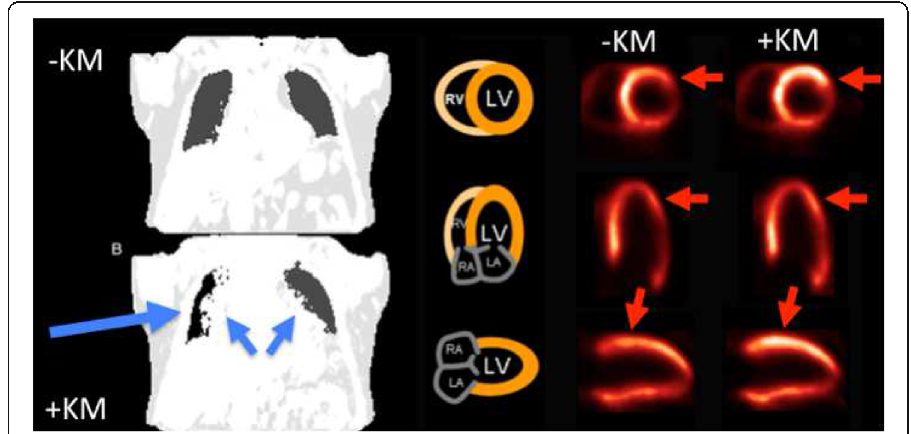
Fig. 3 Effects of contrast media on attenuation-correction in PET/MRI. Attenuation correction (AC)-maps derived from Dixon VIBE MR sequences before (upper row, left) and after contrast media application (bottom row, left). Contrast media application may cause erroneous segmentation of the lungs (right lung: air instead of lung tissue indicated by large blue arrow) and in hilar regions (overestimation of soft tissues bihilarly, small blue arrows). This translates into an erroneous tracer uptake increase on attenuation corrected PET images in the anterolateral wall (red arrows). (Reprinted with permission from Rischpler C, Nekolla SG, PET Clin 11 (2016) 465 – 477